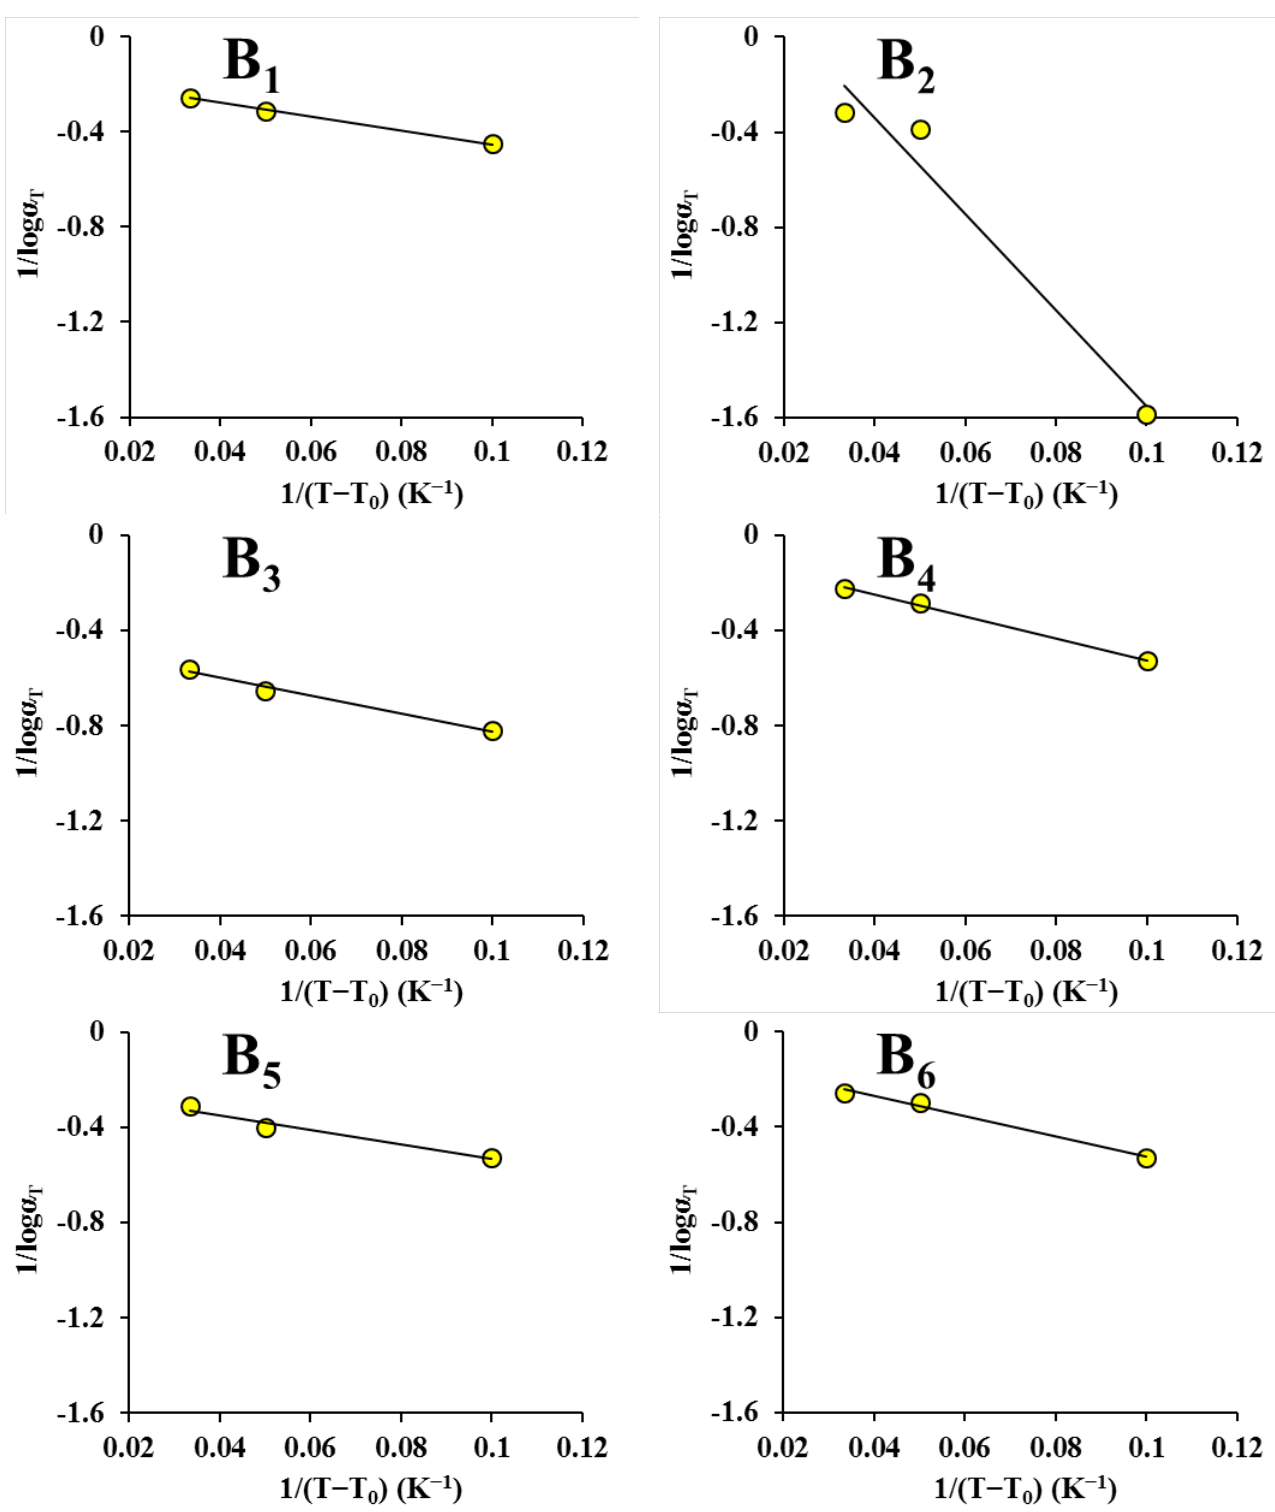
Figure 6. Shift factors fitted to the Arrhenius equation for maize kernels (creep): ( A 1 ) ND; ( A 2 ) HVD 35 °C; ( A 3 ) HVD 45 °C; ( A 4 ) HVD 55 °C; ( A 5 ) HVD 65 °C; ( A 6 ) HVD 75 °C. Shift factors fitted to the WLF equation for maize kernels (creep): ( B 1 ) ND; ( B 2 ) HVD 35 °C; ( B 3 ) HVD 45 °C; ( B 4 ) HVD 55 °C; ( B 5 ) HVD 65 °C; ( B 6 ) HVD 75 °C.